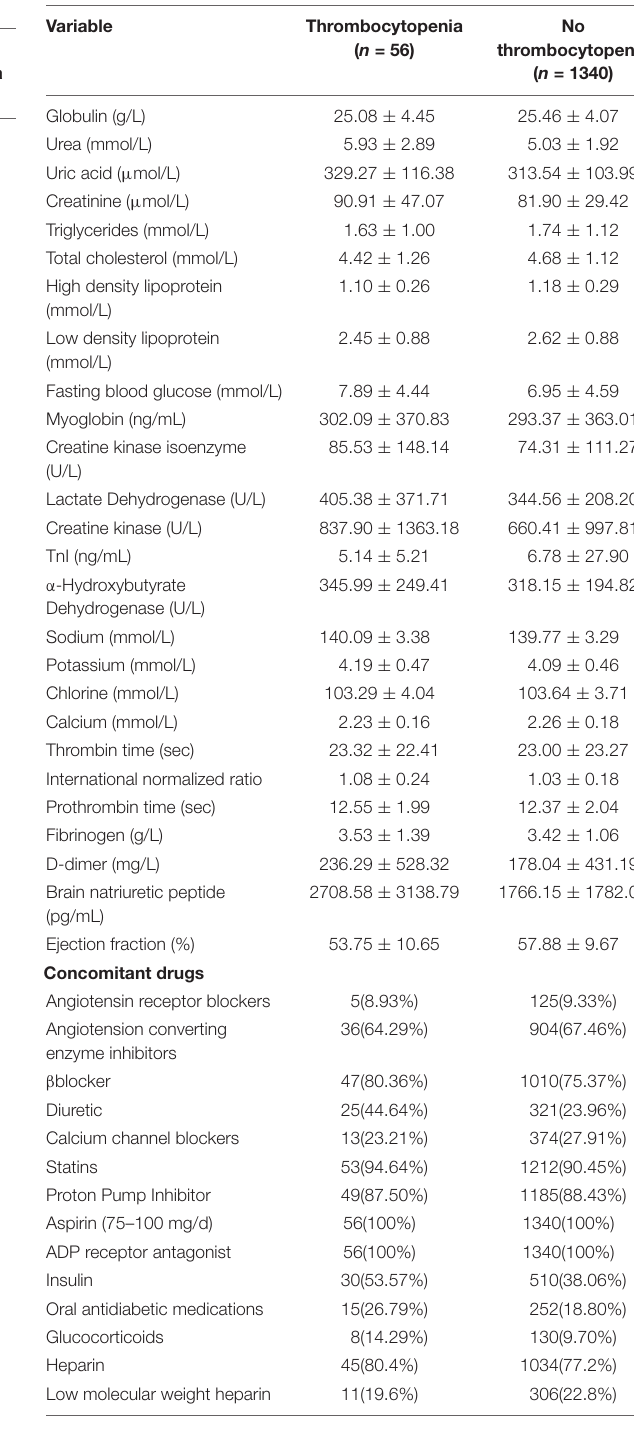
TABLE 1 | Baseline demographic characteristics of patients with and without thrombocytopenia in developmental data